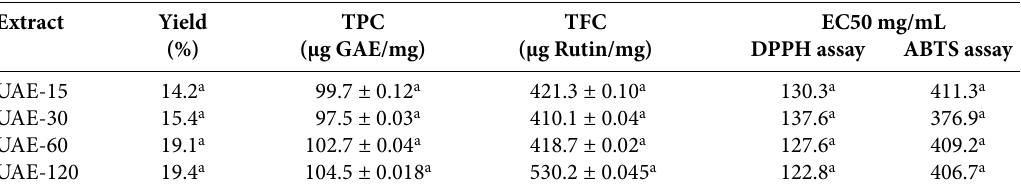
Table 3. Effect of ultrasonication period on antioxidant properties of olive leaf extract